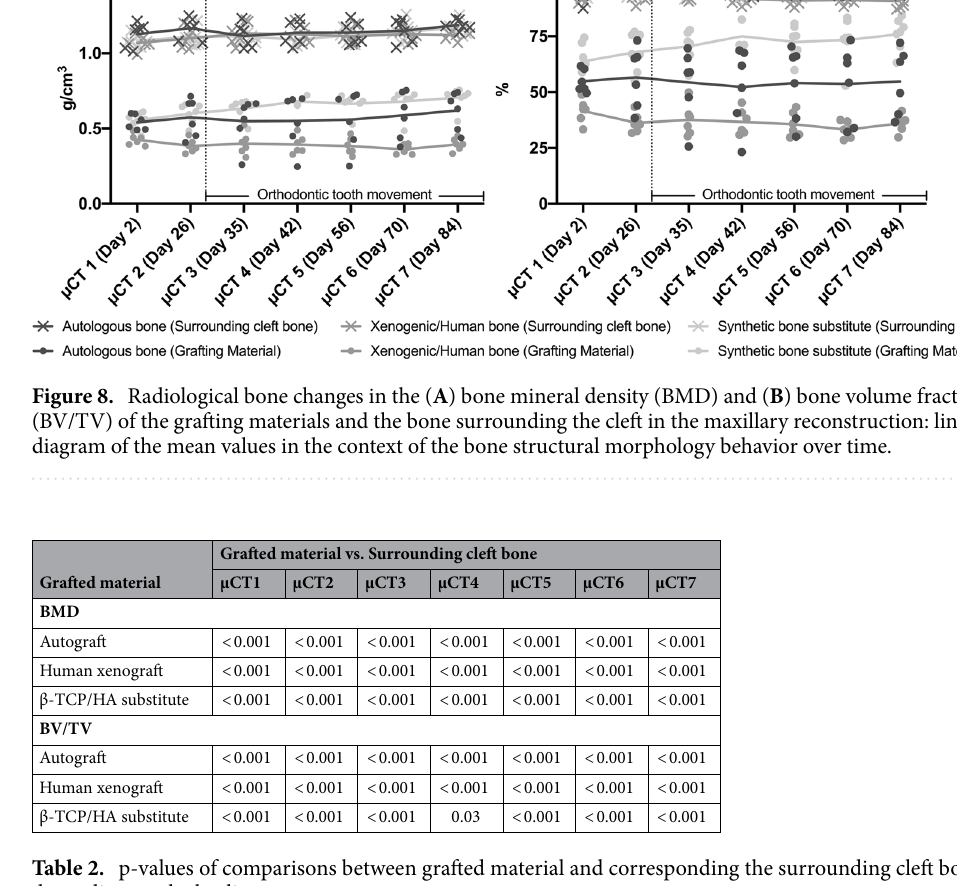
Table 2. p-values of comparisons between grafted material and corresponding the surrounding cleft bone depending on the healing process.